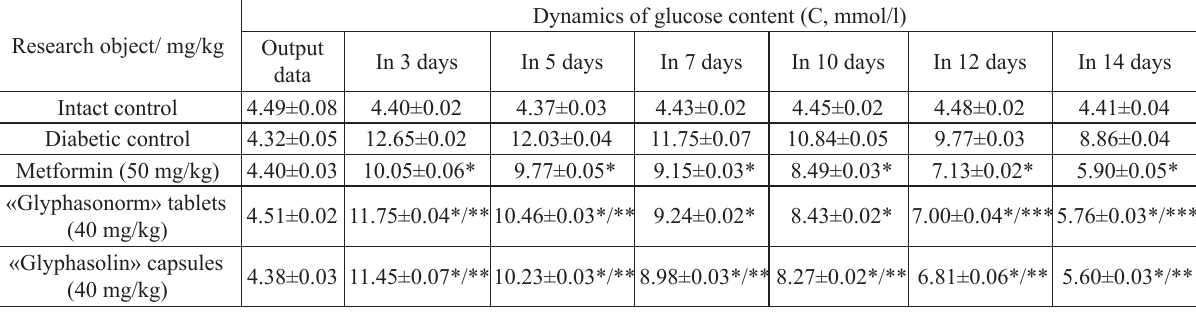
Hypoglycemic activity of “Glyphasonorm” tablets and “Glyphasolin” capsules on the streptozotocin diabetes model in rats with long-term administration,